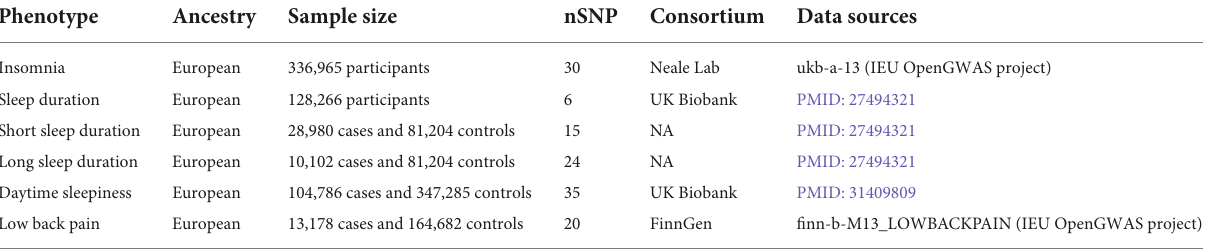
TABLE 2 Description of six GWAS summary